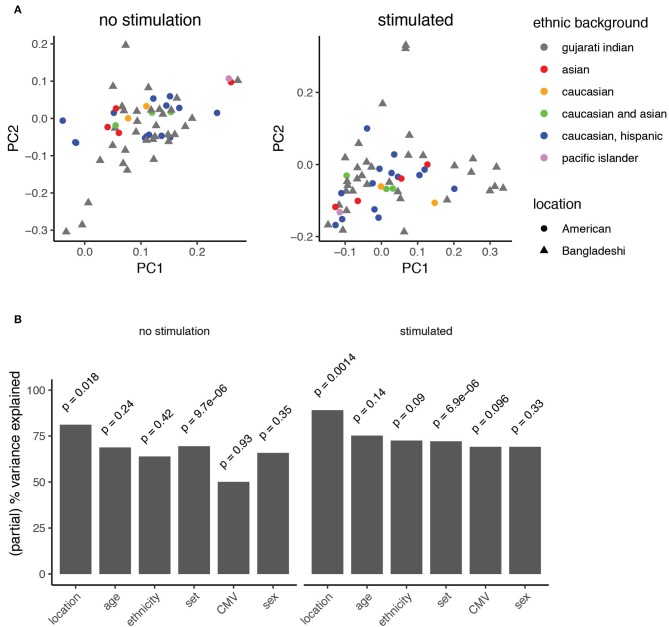
Principal component analysis identifies features explaining immune variation in PBMCs from children. (A) Principal component analysis of automated clustering output from PBMCs either left unstimulated (left) or stimulated with PMA-ionomycin (right). Point shapes represent data from American (circles) and Bangladeshi (triangle) cohorts. Points are filled based on reported ethnic background. (B) Variance explained by known clinical features. A mixed linear model was used to describe the partial variance explained in PBMC samples from unstimulated (left) and stimulated (right) analyses. Partial percent variance explained (partial eta2) calculates the percent variance explained for each variable from the Pillai statistic. A type-II MANOVA test was performed on the linear model and p-values for the contribution of each variable were calculated from the Pillai test statistic.